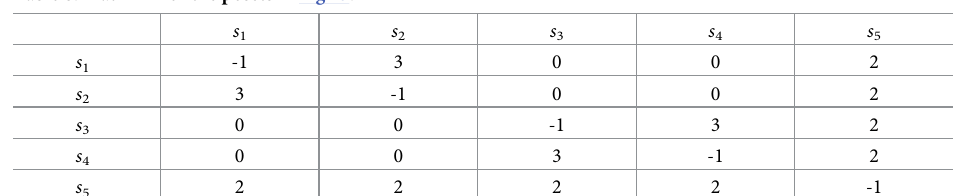
Fig 15. Set of posets P for the set of species S = { s 1 , s 2 , s 3 , s 4 , s 5 }. https://doi.org/10.1371/journal.pone.0281824.g015 Table 8. Matrix A for the posets in Fig